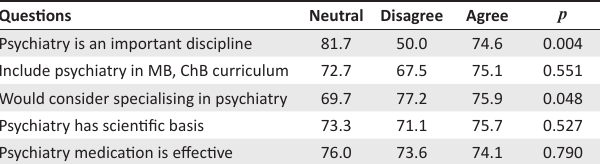
TABLE 6: Students’ mean electroconvulsive therapy knowledge scores across psychiatry attitudinal